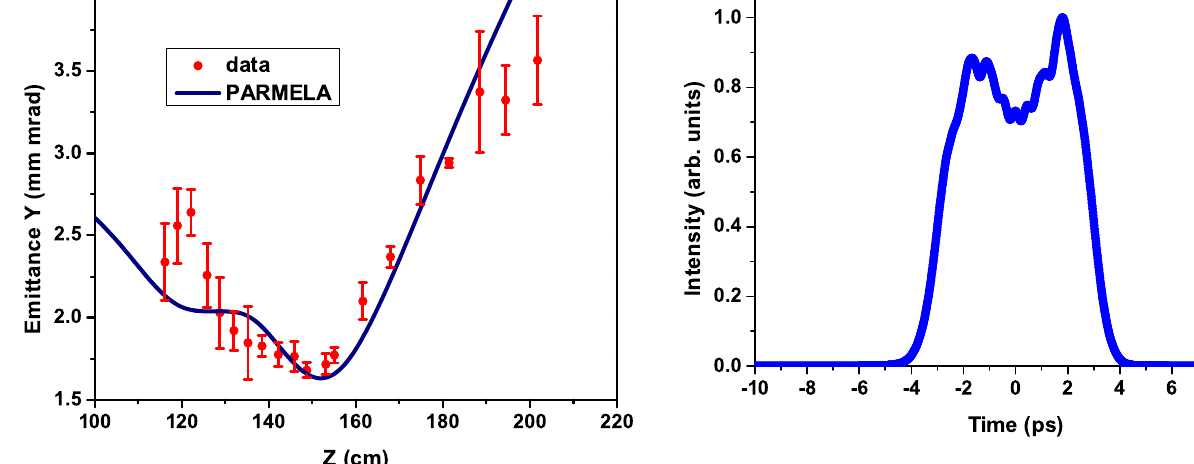
FIG. 19. (Color) Longitudinal profile of the laser for the mea- surement shown in Fig. 20. The rise time is 1.5 ps and the FWHM is 5.5 ps. TABLE V. Parameters of the beam whose emittance measure- ment is shown in Fig. 20.